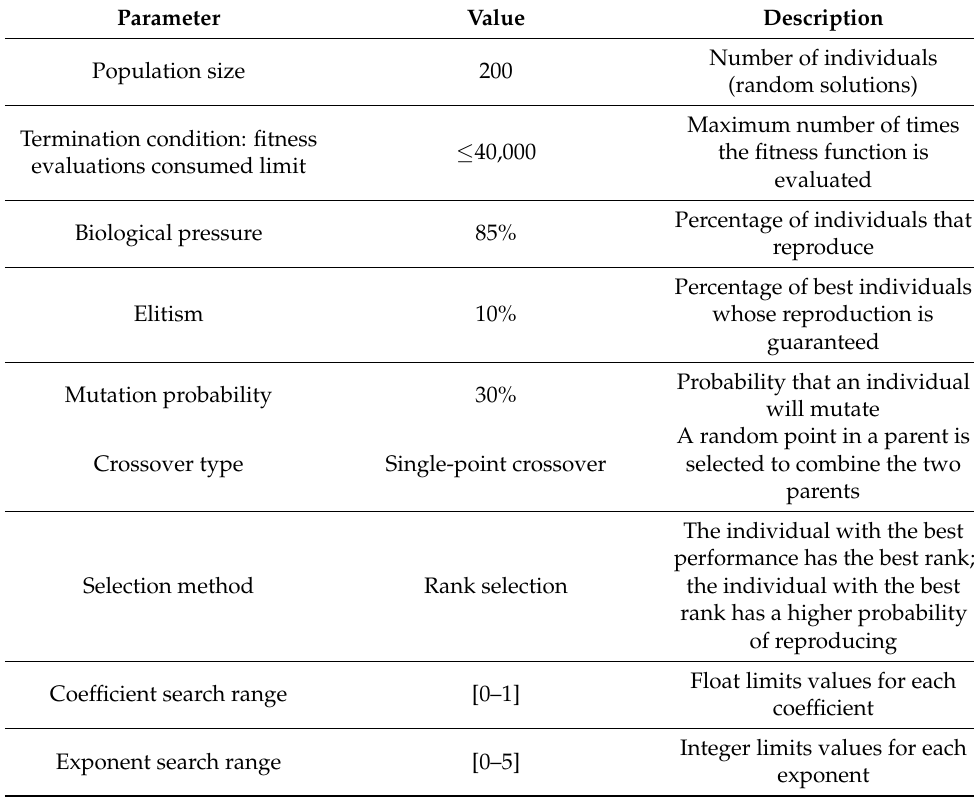
Table 2. Search parameters used for the genetic